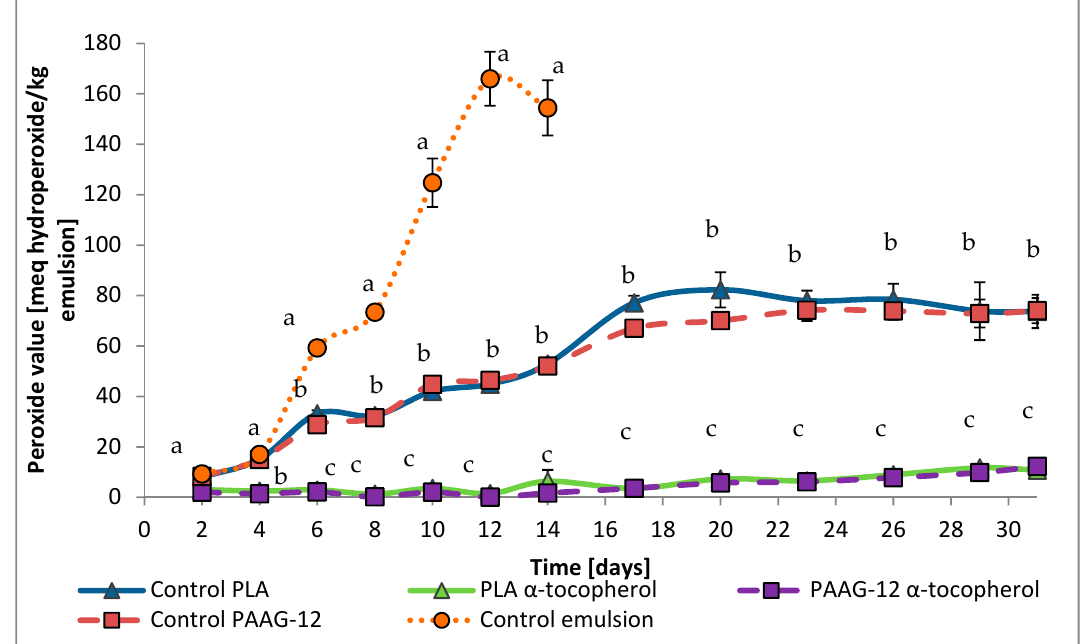
Figure 4. Primary oxidation value by peroxide assay of oil-in-water (O / W) emulsions protected by control emulsion, control PAAG-12, control PLA, PLA α -tocopherol and PAAG-12 α -tocopherol films. Samples with different letters denote significant differences ( p < 0.01) .